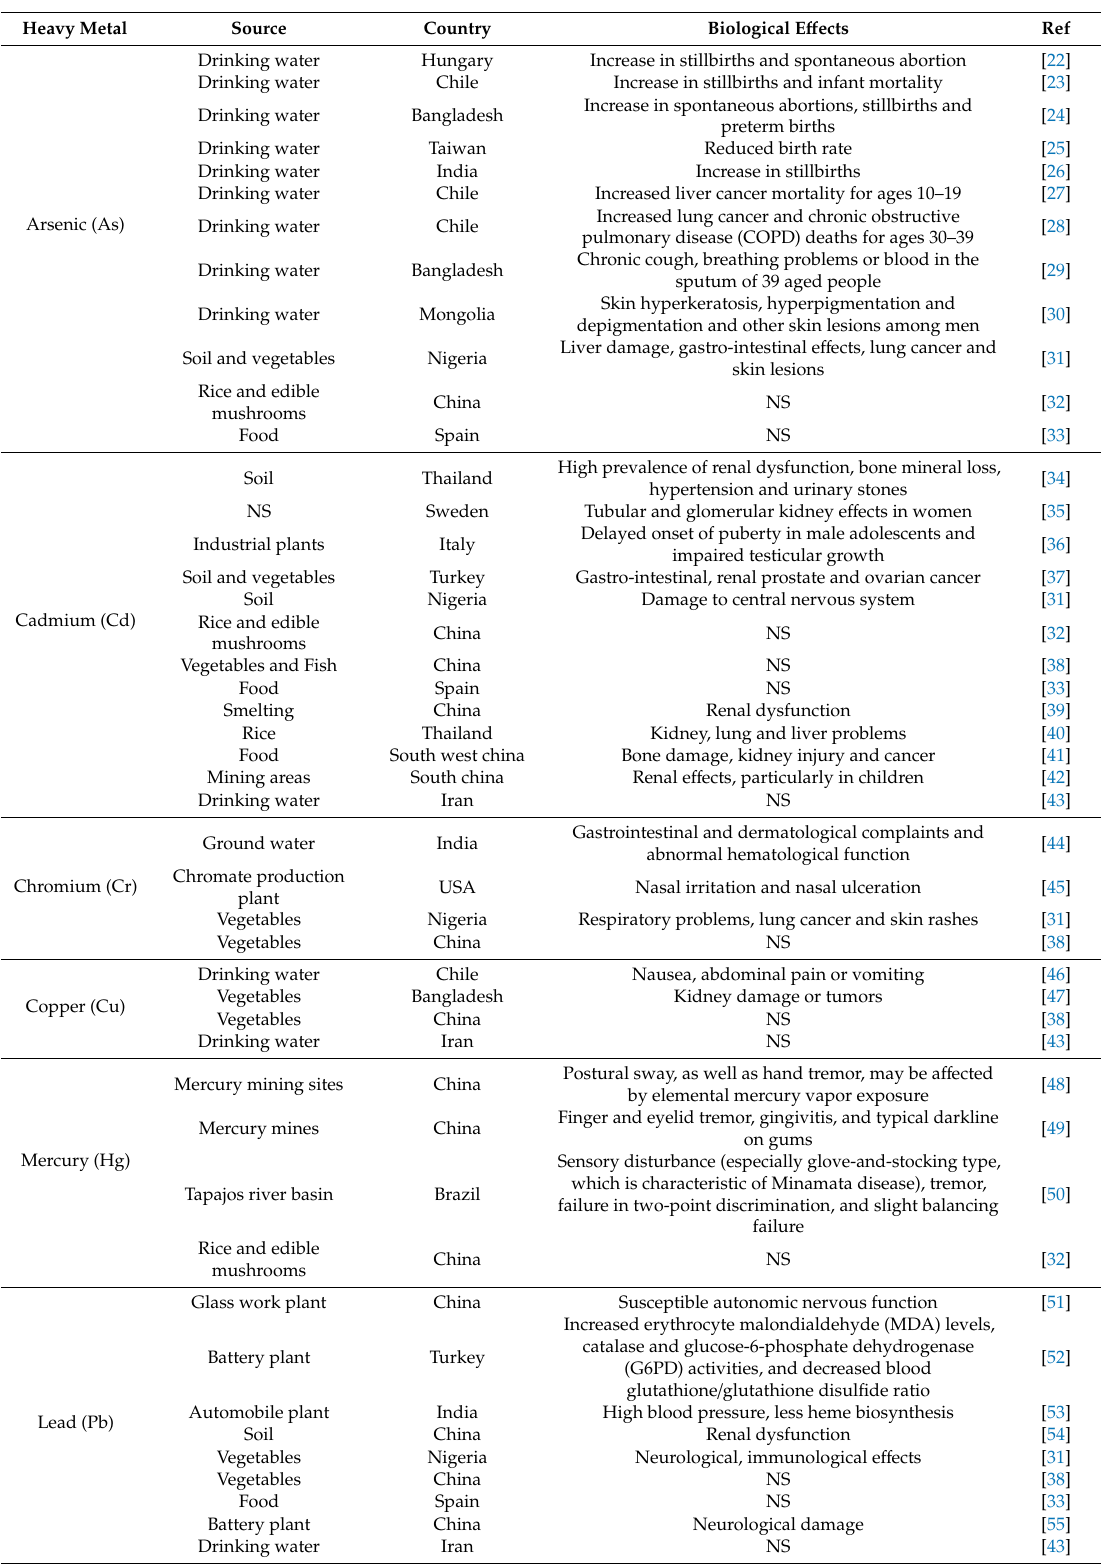
Table 1. Health e ff ects on humans of di ff erent heavy metals (NS—not